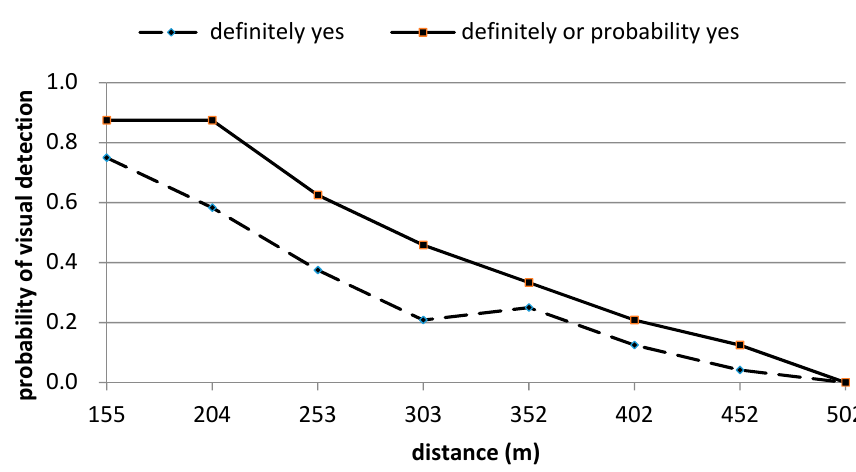
Figure 5. Probability of visual detection of the drone without the protector.